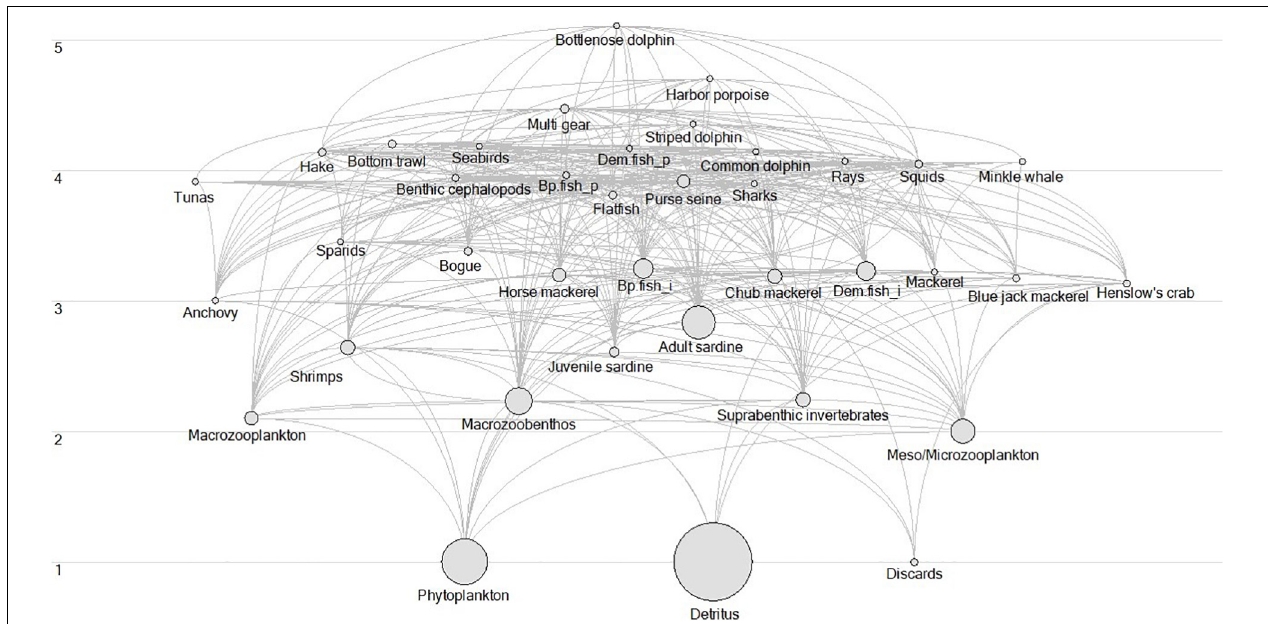
FIGURE 3 | Flow diagram of the Portuguese continental shelf ecosystem (PCSE) in 1986. The list of species and functional groups are described in Veiga-Malta et al. (2019). Acronyms Bp.fish_p is Benthopelagic piscivorous fish, Bp.fish_i, is Benthopelagic invertivorous fish, Dem.fish_i, is Demersal invertivorous fish, Dem.fish_p, is Demersal piscivorous fish, and Suprabenthic inv is Suprabenthic